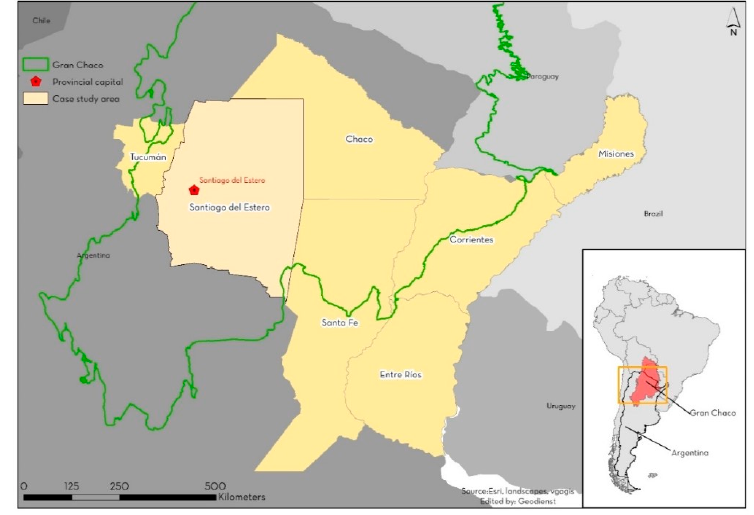
Figure 1. Map of Argentina showing location of Santiago del Estero. Source: Authors.